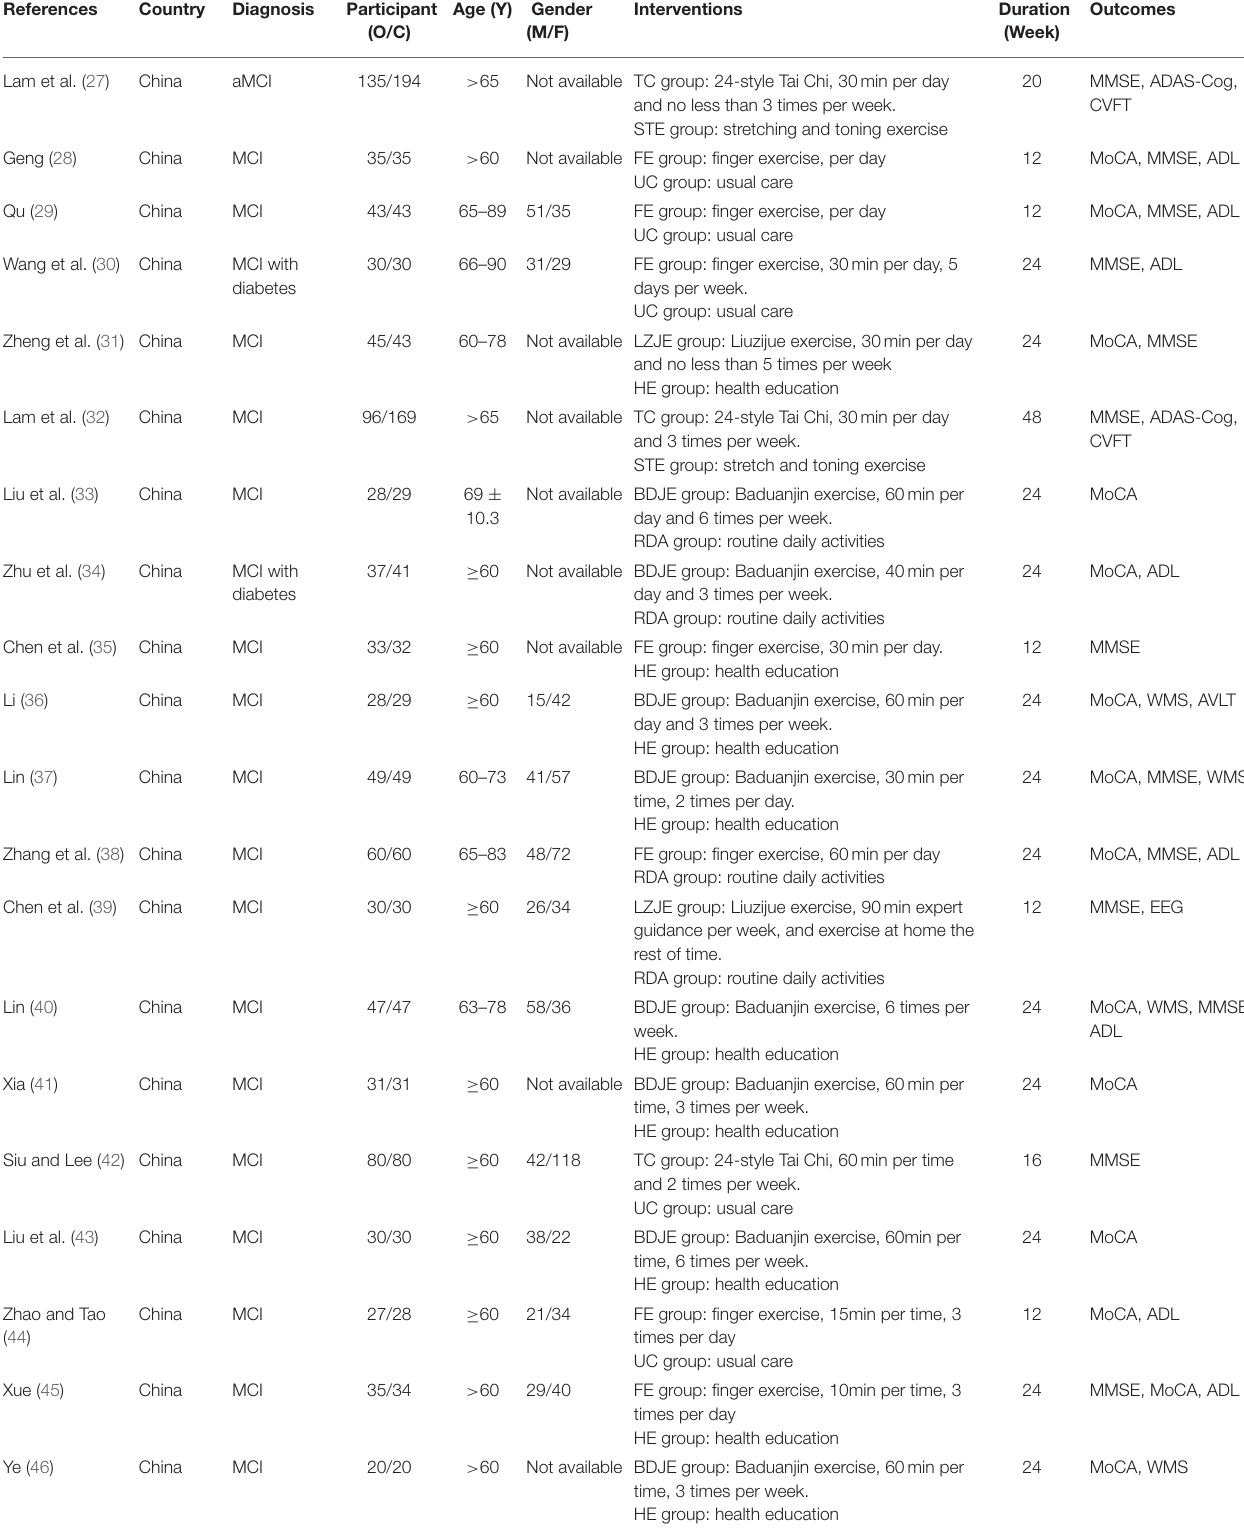
TABLE 1 | Characteristics of included studies in this network